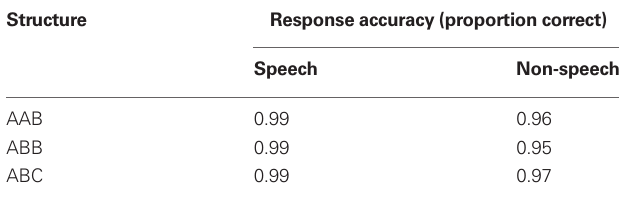
Table 4 | Mean response time and response accuracy in experiment